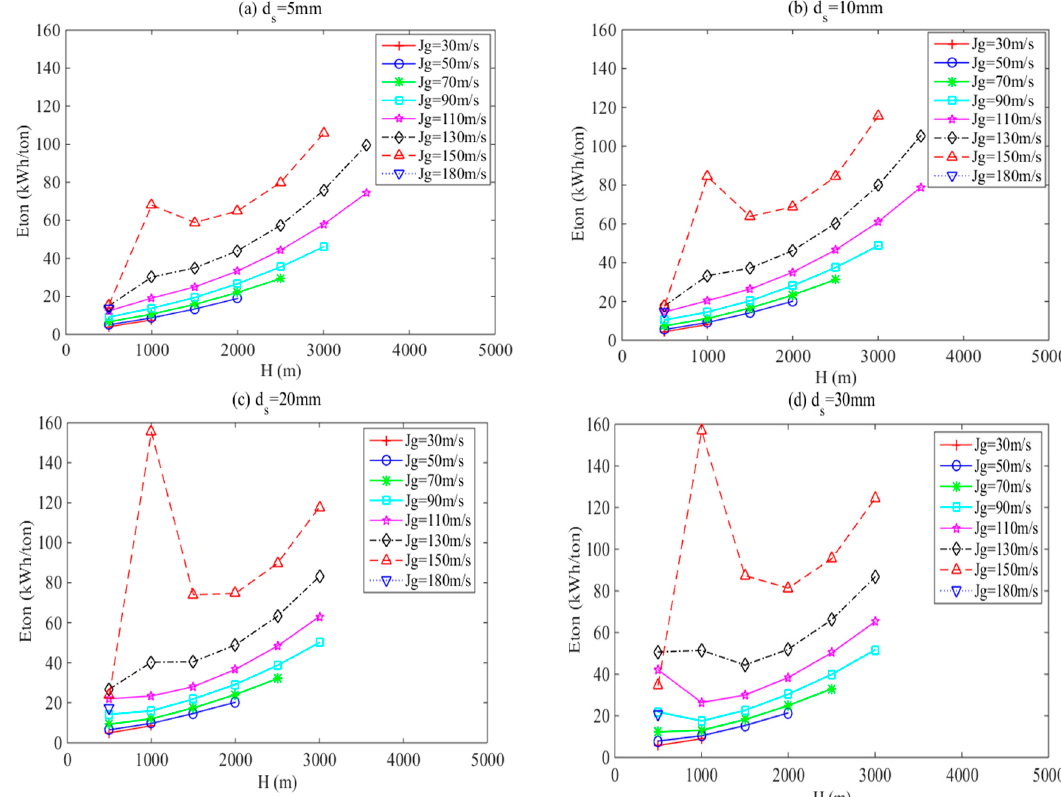
Figure 10. Figure of energy consumption per tonnage of mineral Eton influenced by particle diameter d s at different mining depth H and gas flux rate Jg . The particle diameter of ( a – d ) are 5, 10, 20, 30 mm, respectively.